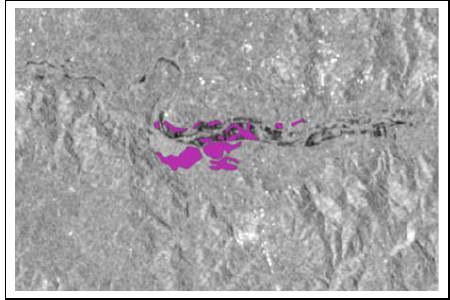
Figure 3. The available information of Copernicus Emergency Management Service (© 2015 European Union), [EMSR337] Alfeios: Delineation Map (in magenta) on Sentinel-1 image (12-